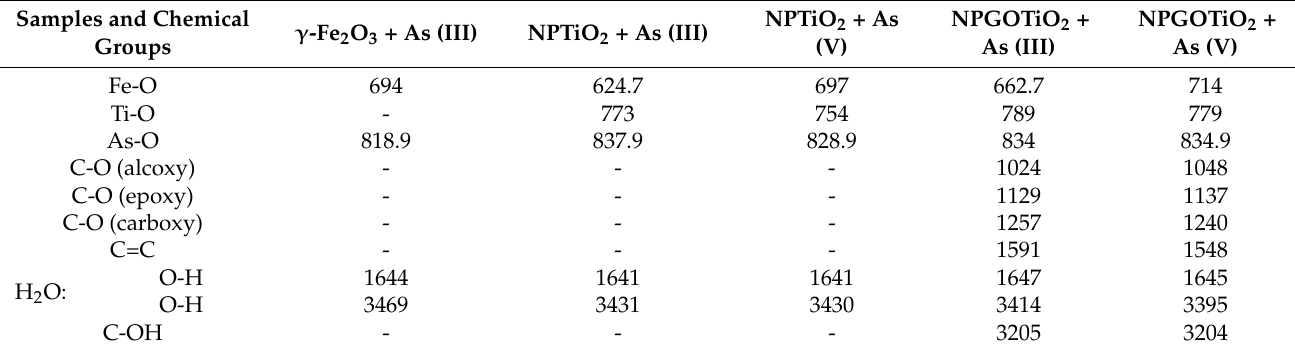
Table 3. Position centers of main modes of vibration. This table was developed from data of the IR spectra shown in Figures 6 and 7.